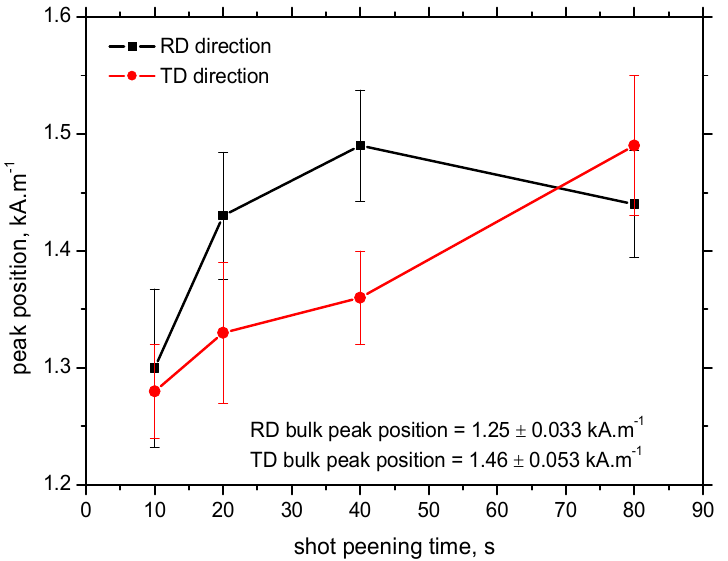
Figure 9. The peak position (PP) of the MBN envelopes for the RD and TD directions.